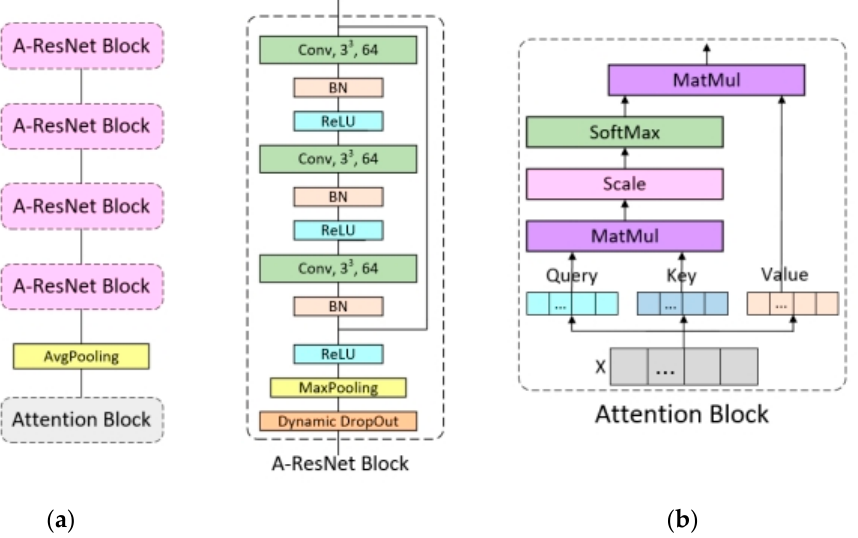
Figure 6. A-ResNet network structure. ( a ) is the overall structure of the A-ResNet network; ( b ) is the Attention Block.